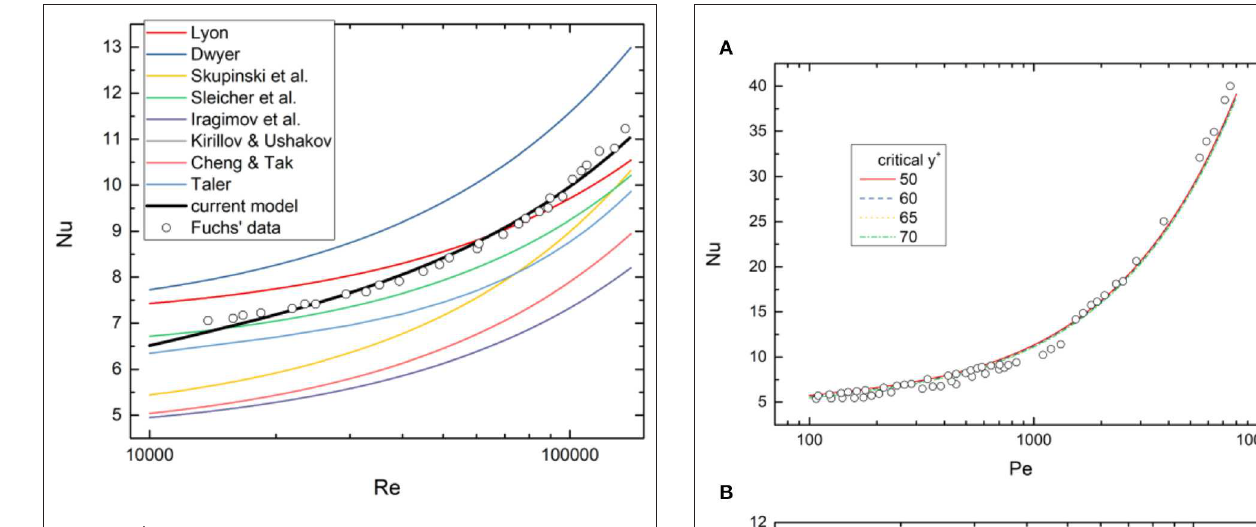
FIGURE 3 | Comparison of the Nusselt number for liquid sodium.